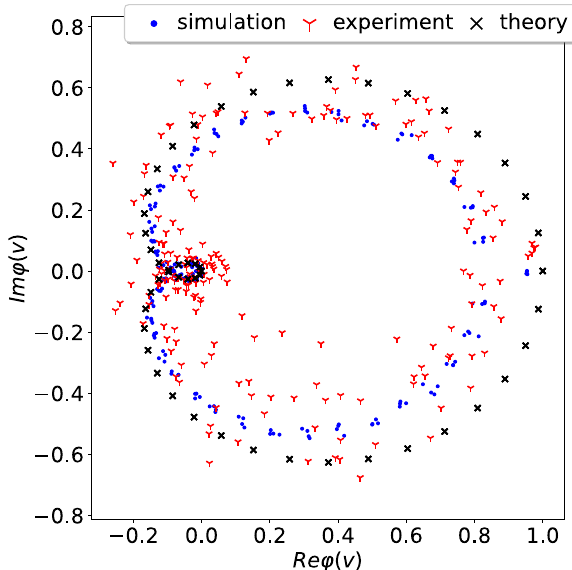
Fig. 5 Characteristic functions of a correlated random walk. Characteristic functions of a random walk is calculated theoretically ( × ), by simulation (dot), and by experiment (tri-down). The simulation includes the standard noise model provided in qiskit. The experiment employs the standard error mitigation technique provided in qiskit. The parameters that de fi ne the correlated random walk is described in the main